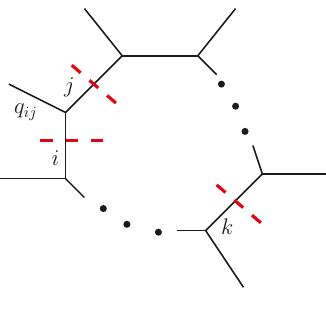
Figure 3 . Diagram representative of a triple